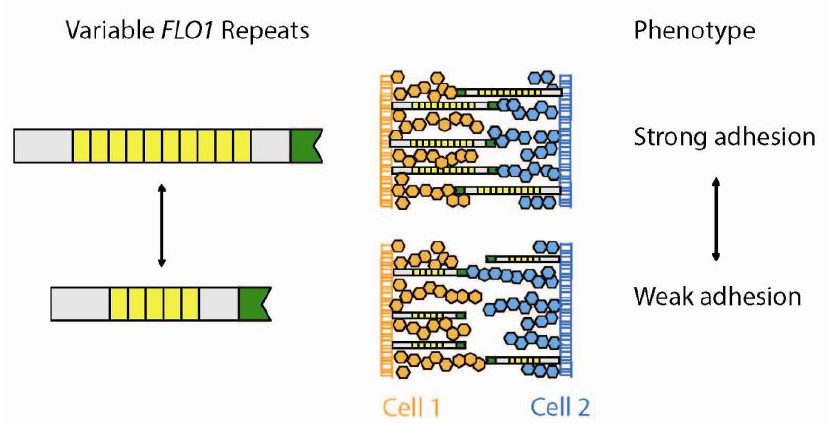
Figure 5. Variable coding TRs modulate cell to cell adhesion. The Flo1 protein binds cell wall polysaccharides (orange and blue hexagons) through its N -terminal domain (green) thus linking two yeast cells. Long FLO1 repeats result in a longer Flo1 protein capable of stronger cell wall